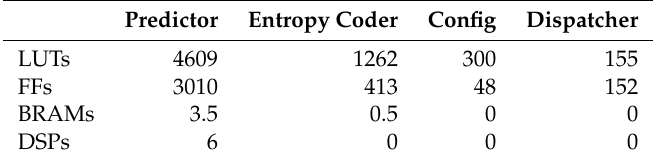
Table 3. FPGA resources used by each module of the CCSDS 123.0-B-1 IP core (synthetic image).